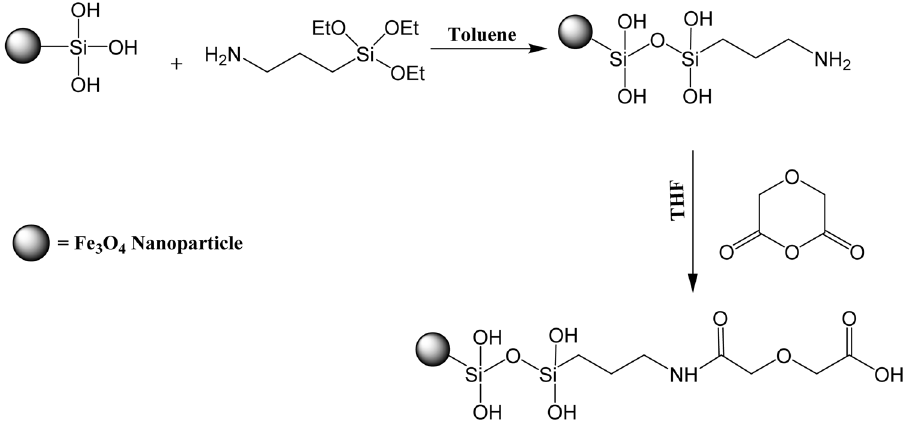
Figure 1. Reaction scheme for synthesis of